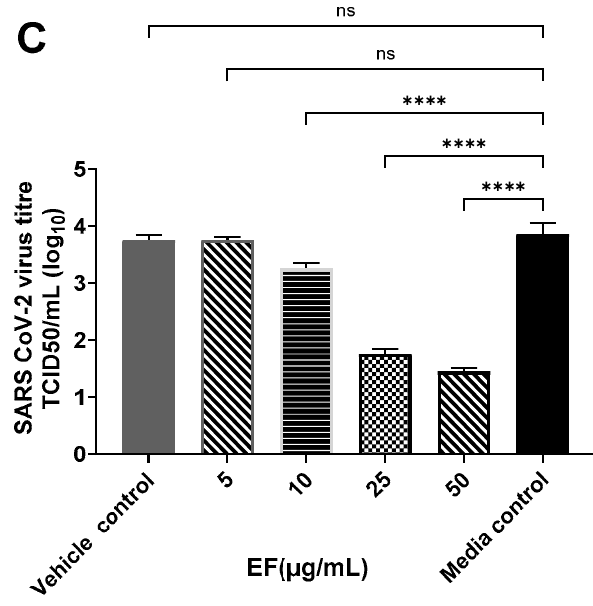
Figure 3. Infection preventive (antiviral) effect of EF on pretreated human airway epithelial cells. EF prevented OC43 ( A ) and SARS-CoV-2 (HU-1, ( B , C )) infection dose-dependently in pretreated HNEpC and HBEpC. Cells were pretreated with EF for 24 h and infected with virus at MOI of 1. Viral titer was measured at 72 h pi. Data resulted from 3 independent experiments. One-way ANOVA with Bonferroni multiple comparison correction was performed (****: p ≤ 0.0001).